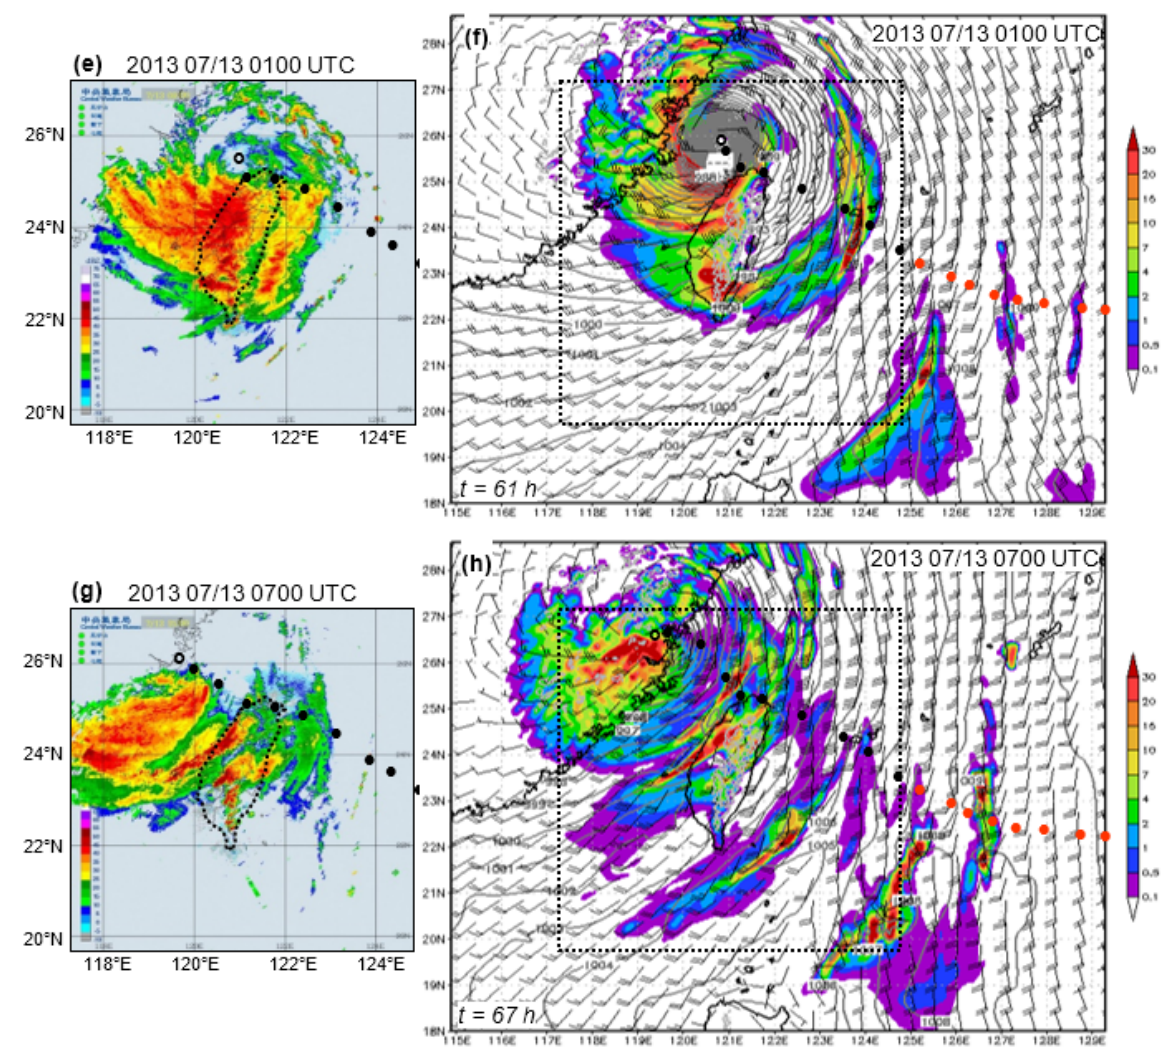
Figure 3. ( a ) Radar VMI reflectivity composite (dBZ, scale at lower left, every 5 dBZ from − 10 to 75 dBZ) at 2:00 p.m. UTC 12 July (provided by the CWB) and ( b ) CReSS forecast ( t 0 at 12:00 p.m. UTC 10 July) of sea-level pressure (hPa, every 1 hPa, over ocean only), surface wind (kts, barbs) at 10 m height, terrain elevation (gray contours at 1 and 2 km, over land only), and 1 h rainfall (mm, color, scale to the right) valid at 12:00 p.m. UTC 12 July 2013. ( c , e , g ) As in ( a ), but for radar reflectivity at ( c ) 7:00 p.m. UTC 12, and ( e ) 1:00 a.m. and ( g ) 7:00 a.m. UTC 13 July 2013. ( d , f , h ) As in ( b ), but for forecast valid at ( d ) 5:00 p.m. UTC 12, and ( f ) 1:00 a.m. and ( h ) 7:00 a.m. UTC 13 July 2013. The current typhoon center is marked by an open dot, and the earlier positions every 3 h (at 12:00 a.m. UTC, 3:00 a.m. UTC, etc.) are marked by solid dots (in orange prior to 6:00 a.m. UTC 12 July). The dotted box in model plots corresponds to the region of radar plots. The 24 h total rainfall distributions over Taiwan from rain-gauge observations for